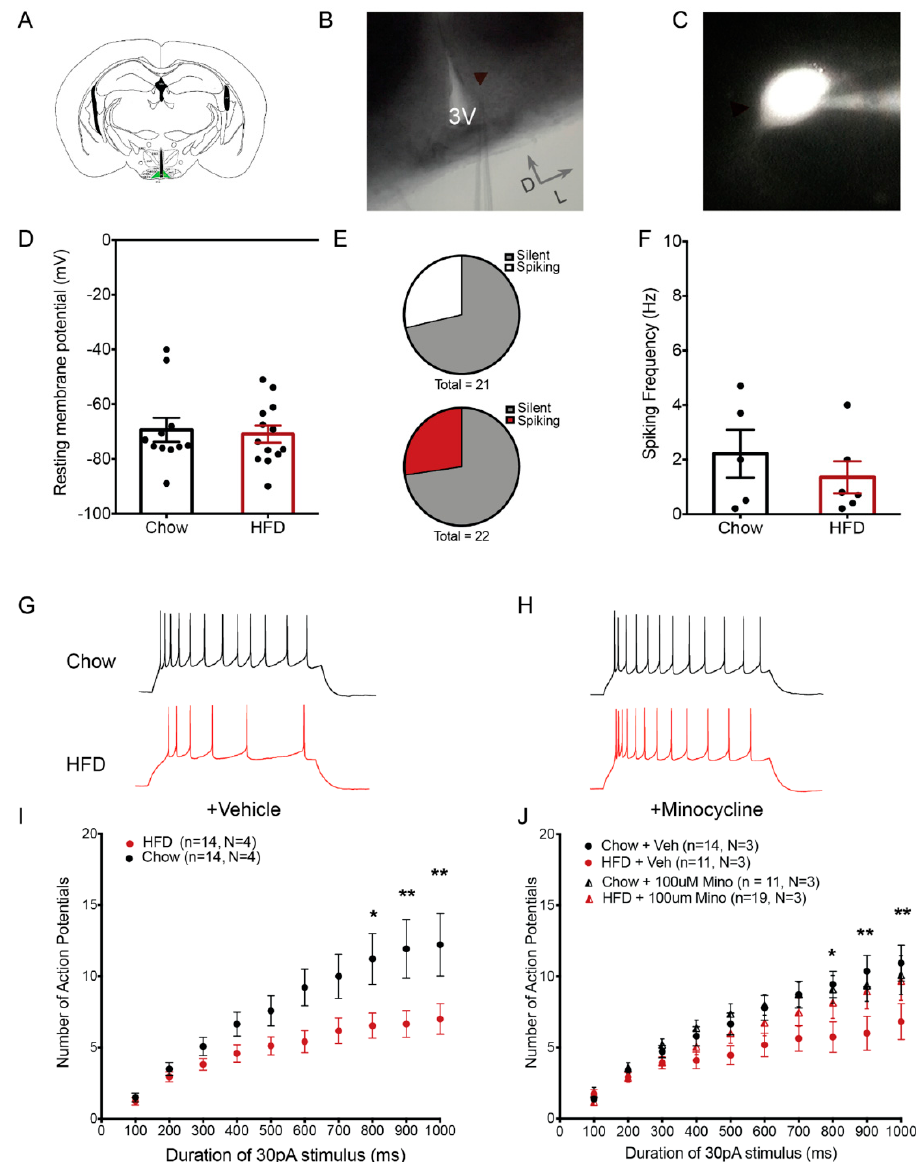
Figure 2. Minocycline restores intrinsic excitability of POMC neurons in HFD-fed mice. ( A ) Schematic diagram showing a coronal hypothalamic slice. The arcuate nucleus (ARC), where GFP-expressing POMC neurons were visualized and recorded from, is highlighted in green. ( B ) 4X DIC image showing the ARC region and recording pipette attached to a recorded POMC neuron. ( C ) Representative fluorescent image of a GFP-expressing POMC neuron with attached recording pipette filled with internal solution containing fluorophore Alexa-594. ( D ) Resting membrane potential of recorded POMC neurons (Chow: − 69.38 ± 4.3 mV, n = 11, N = 3; HFD: − 70.92 ± 3.1 mV, n = 13, N = 3). ( E ) Proportion of recorded POMC neurons showing spontaneous activity (upper: Chow (6 out of 21 neurons), lower: HFD (6 out of 22 neurons)). ( F ) Frequency of action potentials in spontaneously firing POMC neurons (Chow: 2.220 ± 0.87 Hz, n = 6, N = 5; HFD: 1.35 ± 0.58 Hz, n = 6, N = 5). ( G , H ) Representative traces of POMC neuron responses after stimulation by 1000 ms 30 pA current step in brain slices from chow and HFD-fed mice treated with vehicle ( G ) or minocycline (100µM) ( H ). ( I , J ) Population data of evoked responses of POMC neurons to variable duration of stimulus in brain slices from chow and HFD-fed mice incubated with vehicle ( I ) or minocycline ( J ). Lowercase (n) indicates number of neurons and uppercase (N) number of animals. * p < 0.05; ** p < 0.01.